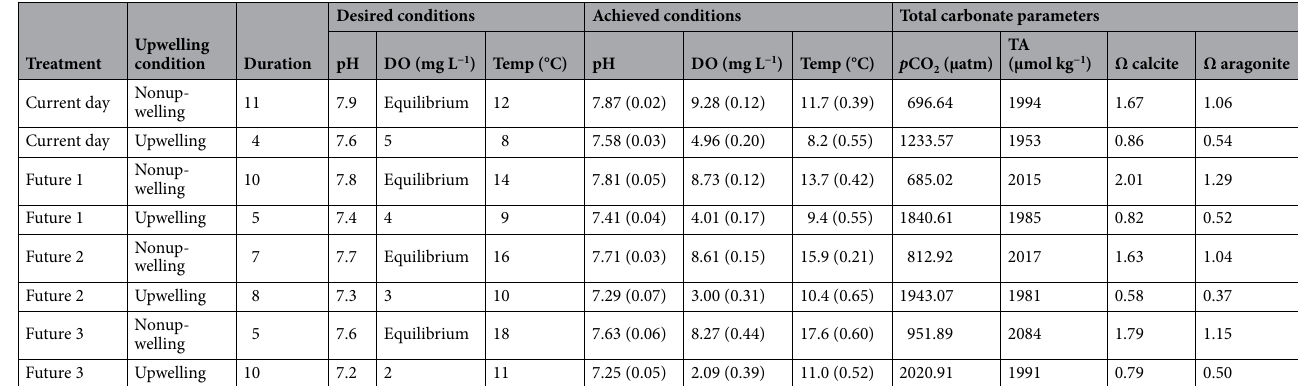
Table 1. Desired, achieved, and associated carbonate chemistry parameters for each treatment in the mesocosm experiment. Achieved conditions are hourly averages and numbers in parentheses are standard deviations.